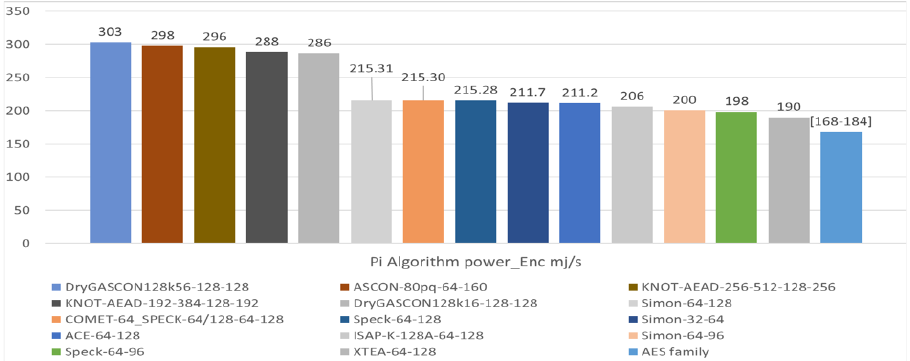
Figure 18. The 10 least power in ENC and 5 biggest in Pi.